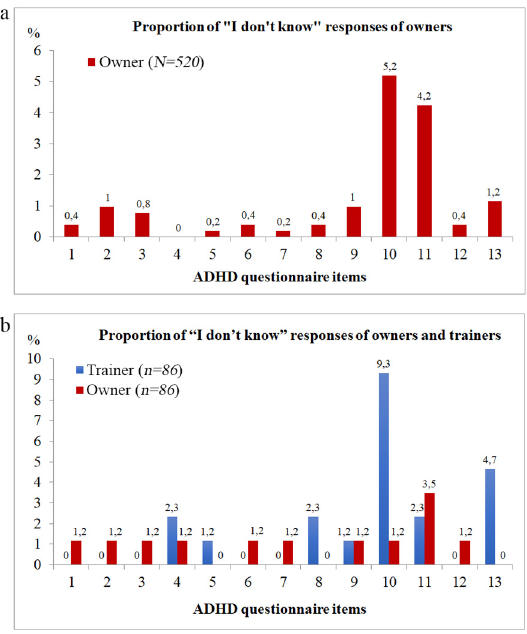
Figure 2. The association between training status and inattention ( a ) and hyperactivity/impulsivity ( b ); * indicates significant differences ( p < 0.05).